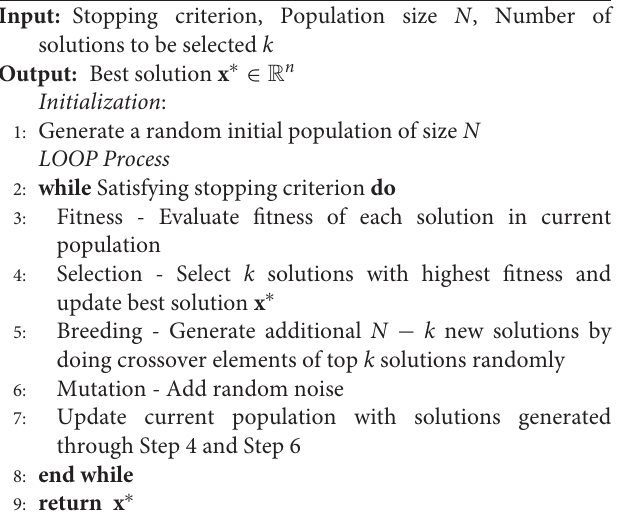
Algorithm 1 | Standard Genetic Algorithm.